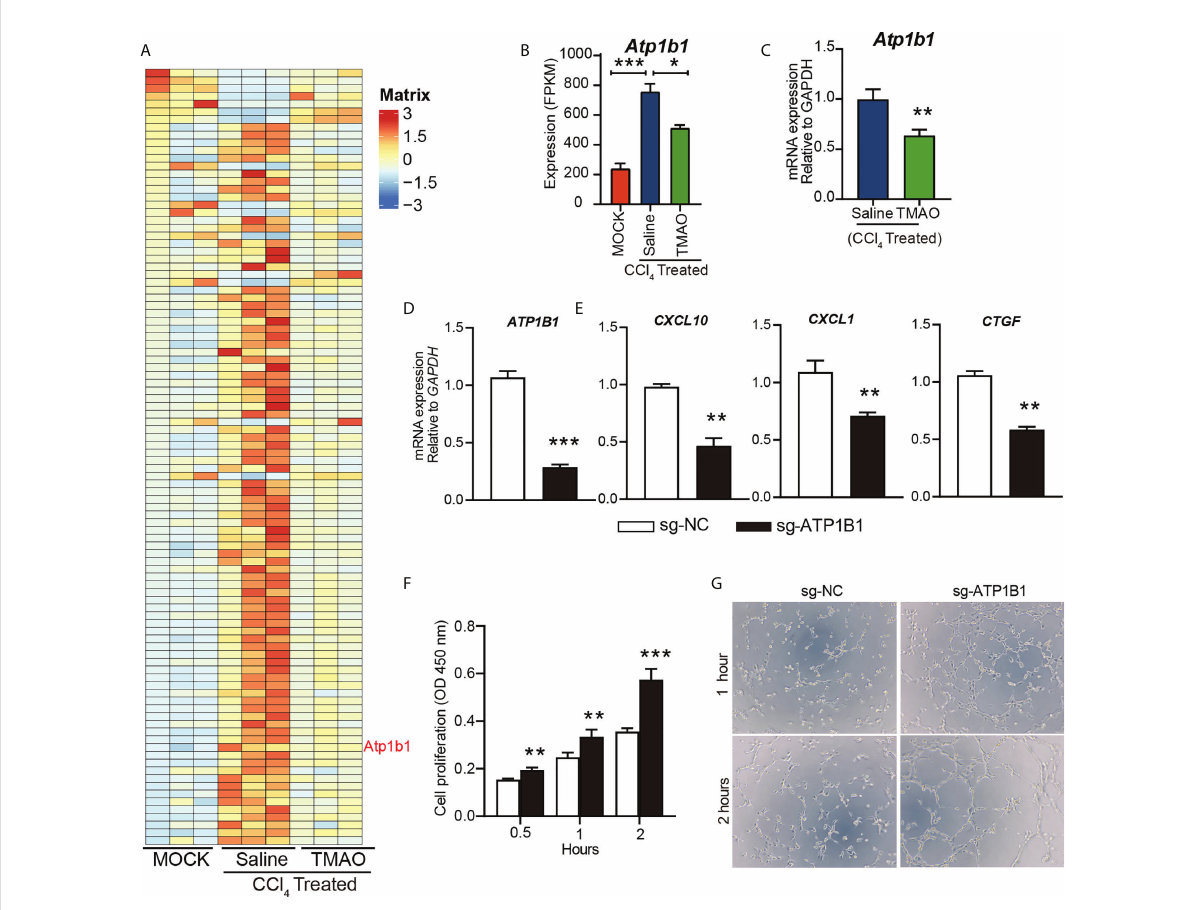
FIGURE 5 TMAO inhibits the expression of ATP1B1 in vascular endothelial cells (A-B) Heatmap depicting the differential gene expression levels in endothelial cells (A) . FPKM levels of ATP1B1 (B) (C) ATP1B1 expression levels decreased after TMAO treatment. (D) Knockdown of ATP1B1 with CRISPR – Cas9 in HUVECs. (E) mRNA levels of CXCL10, CXCL1 and CTGF in HUVECs treated with sg-ATP1B1. (F) The effects of ATP1B1 on cell proliferation in HUVECs by CCK8. (G) The effects of ATP1B1 on vascular formation ability in HUVECs by tube formation assay. *p<0.05, **p<0.01,